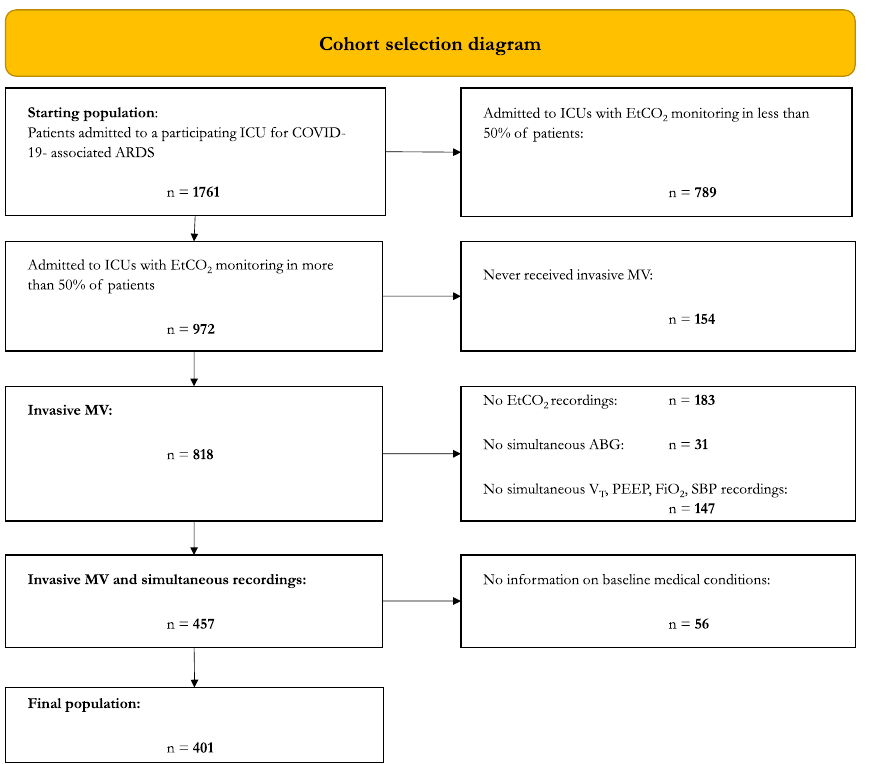
Figure 1. Cohort selection diagram. ABG arterial blood gas, ARDS acute respiratory distress syndrome, EtCO 2 end-tidal partial pressure of carbon dioxide (in mmHg), FiO 2 fraction of inspired oxygen, ICU intensive care unit, MV mechanical ventilation, PEEP positive end-expiratory pressure (in cmH 2 O), SBP systolic blood pressure, V T set or measured tidal volume (in